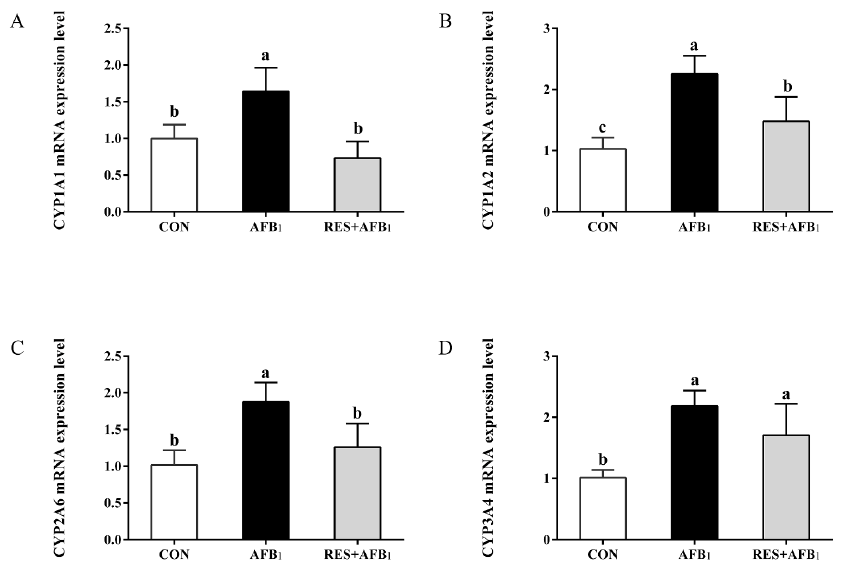
Figure 1. ( A – D ) Effect of RES on the mRNA expression levels of CYP enzymes in the ileum of AFB 1 - exposed ducks. Values are expressed as mean ± SD, n = 8. Labeled (a, b, c, a > b > c) means in a row without a common letter differ, p < 0.05. CYP1A1: Cytochrome P4501A1; CYP1A2: Cytochrome P4501A2; CYP2A6: Cytochrome P4502A6; CYP3A4: Cytochrome P4503A4. P4501A2; CYP2A6: Cytochrome P4502A6; CYP3A4: Cytochrome